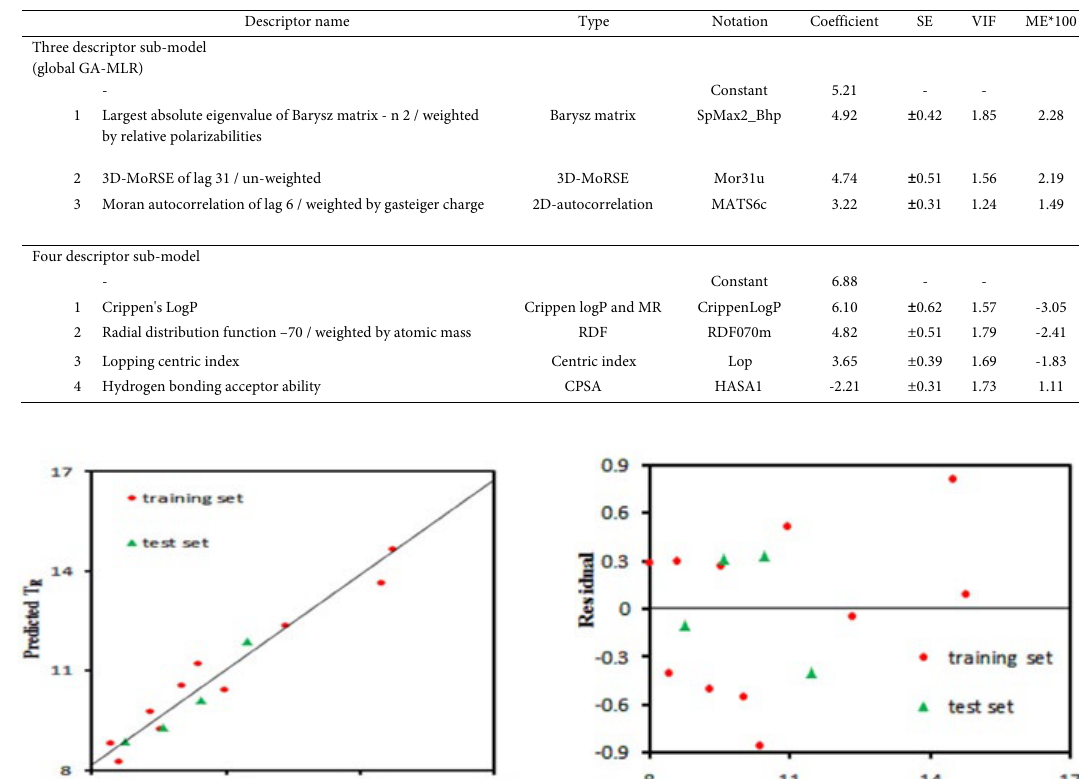
Table 2. Names, definitions, and coefficients of descriptors appearing in ACM.